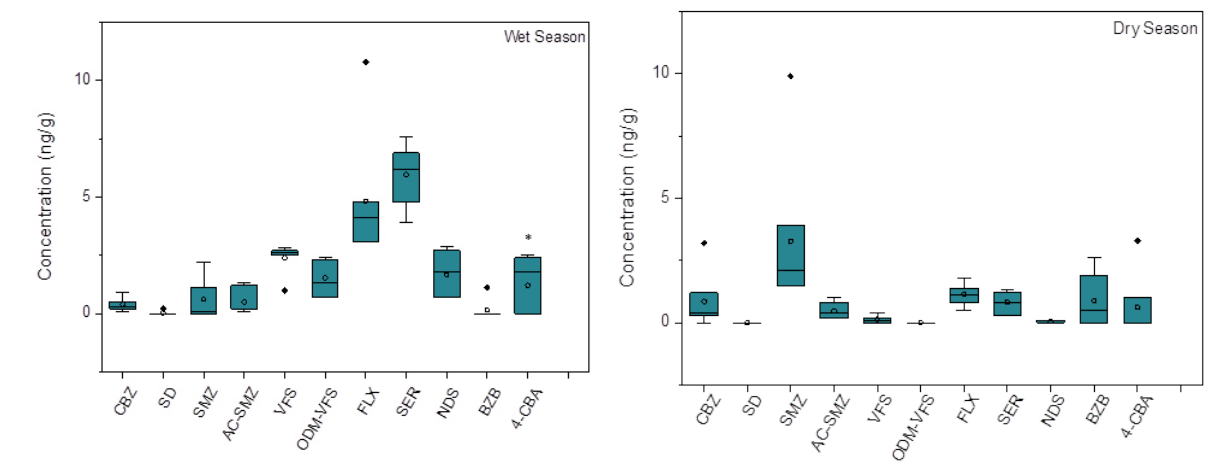
Figure 5. The concentrations of pharmaceutical metabolites and their parents in the sediment of Yunliang river in the wet and dry seasons. * refers to the significant difference between the concentrations of metabolites and their related parents in the same season.